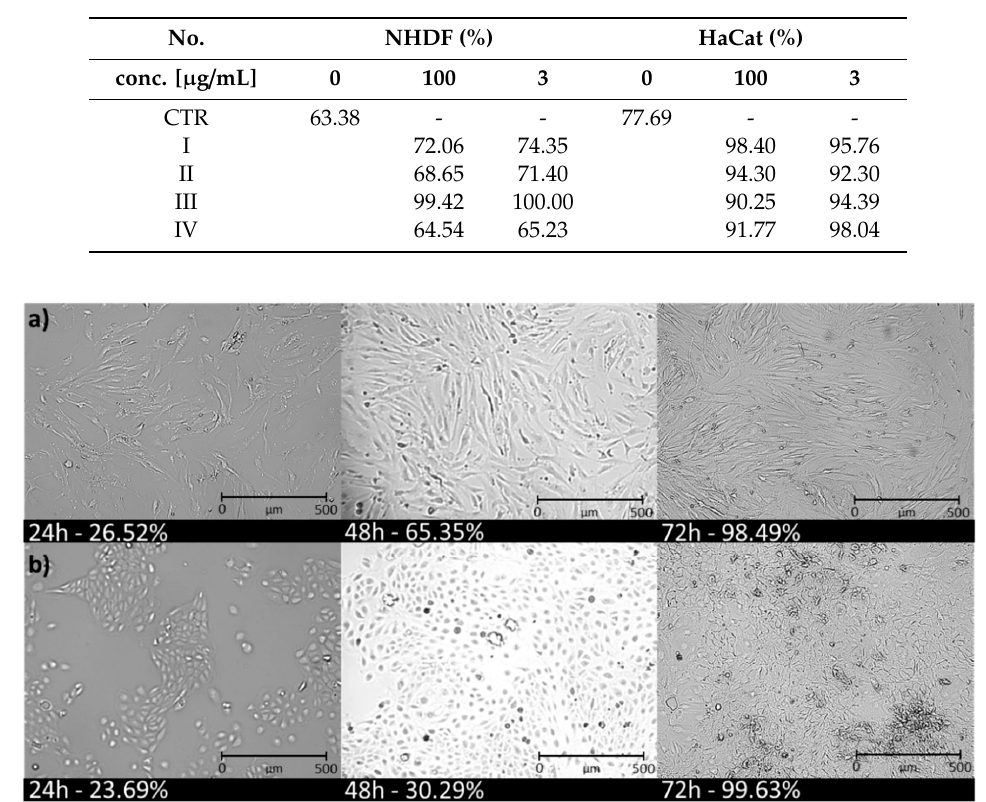
Figure 6. Increase in confluency of ( a ) normal human dermal fibroblasts (NHDF), ( b ) human epidermal keratinocyte (HaCaT) cells treated with PEG graft copolymer-based conjugate III (c = 100 µ g /